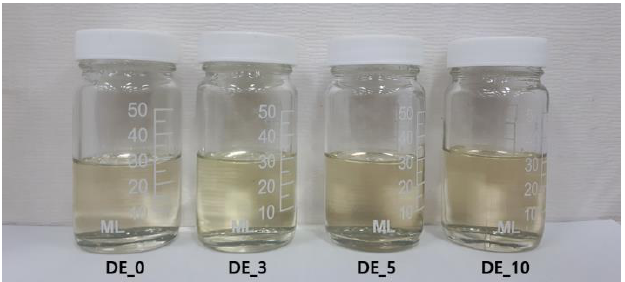
Figure 1. Experimental fuels blended with ethanol in diesel.